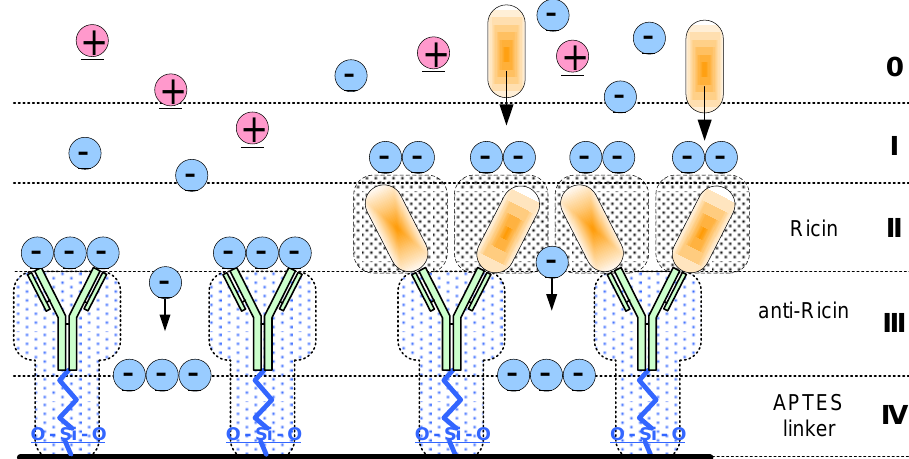
Figure 8. Schematic diagram of anti-Ricin molecules immobilized onto surface and suggested zoned distribution of positive and negative ions from the sample